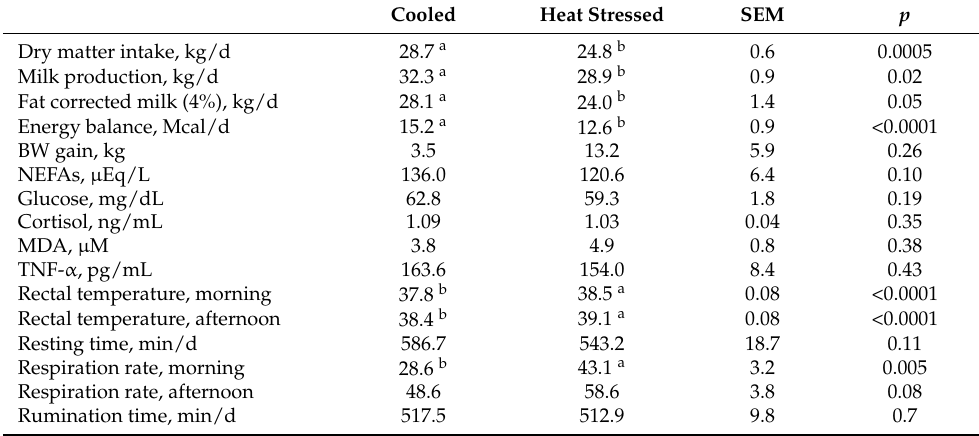
NEFAs = Non-esterified fatty acids; MDA = Malondialdehyde; TNF- α = Tumor necrosis factor alpha; BW = Body weight. a,b Different letters within a row are significant at p < 0.05.